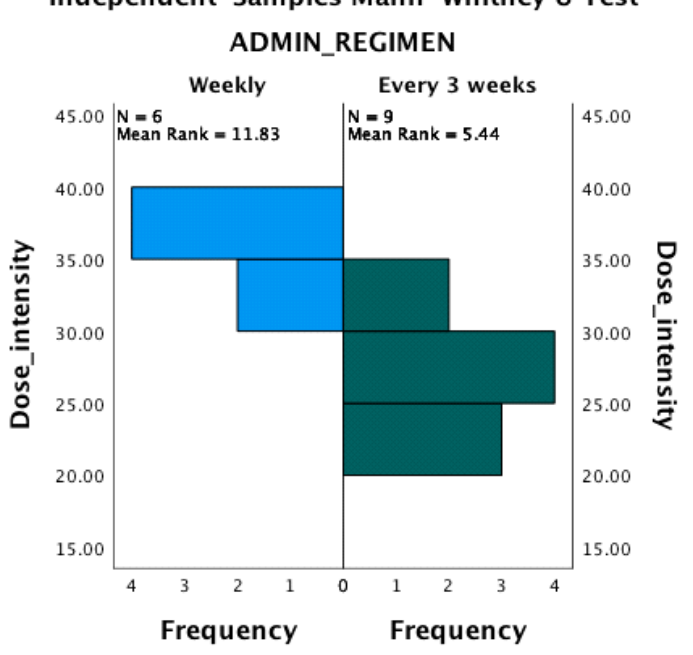
Figure 3. The number of subjects with epiphora is similar for dose intensity lower and greater than 30 mg/m 2 /week.